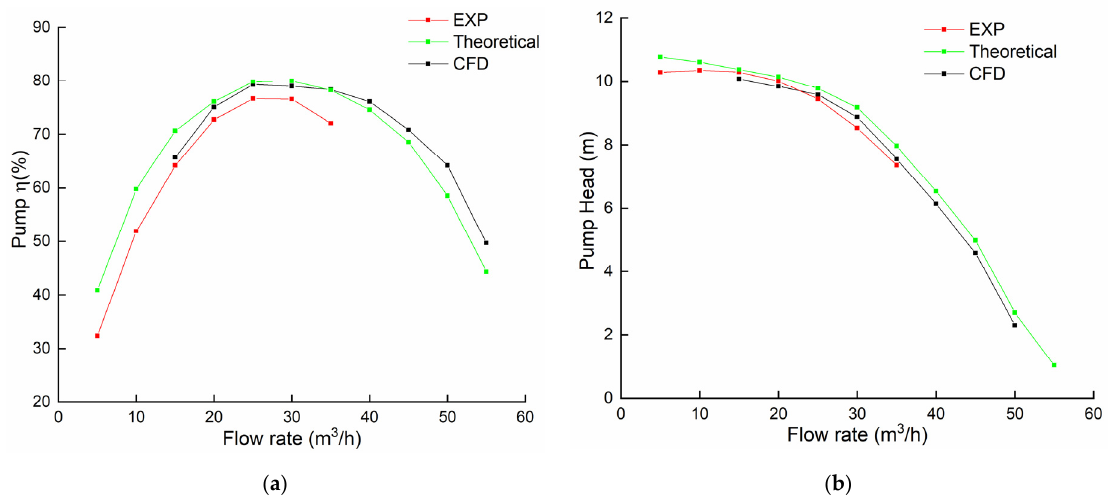
Figure 15. Prediction performance of PAT for ( a ) pump mode efficiency ( b ) pump mode head.